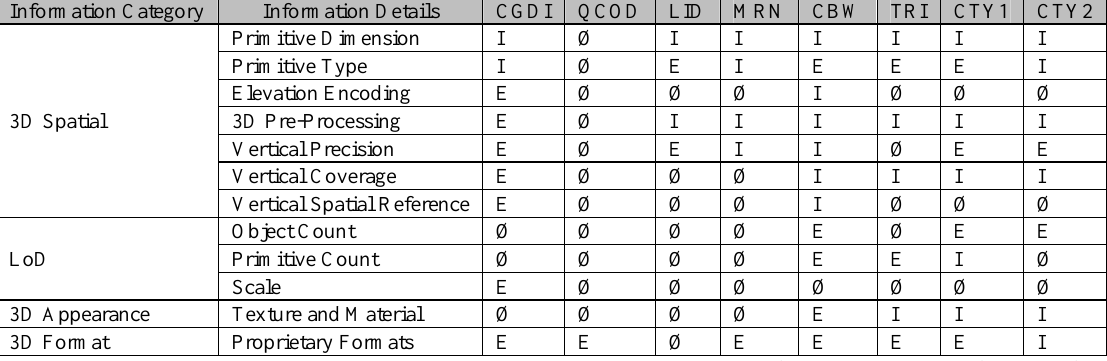
Table 1. The metadata noticed among eight inventoried resources are labeled by “E” for noticed in explicit fields, “I” for noticed in implicit fields (e.g. written summaries), and “ Ø ” for not noticed at all. In header row, the acronyms (e.g. CGDI) represent inventoried resources. For full names see Section 3